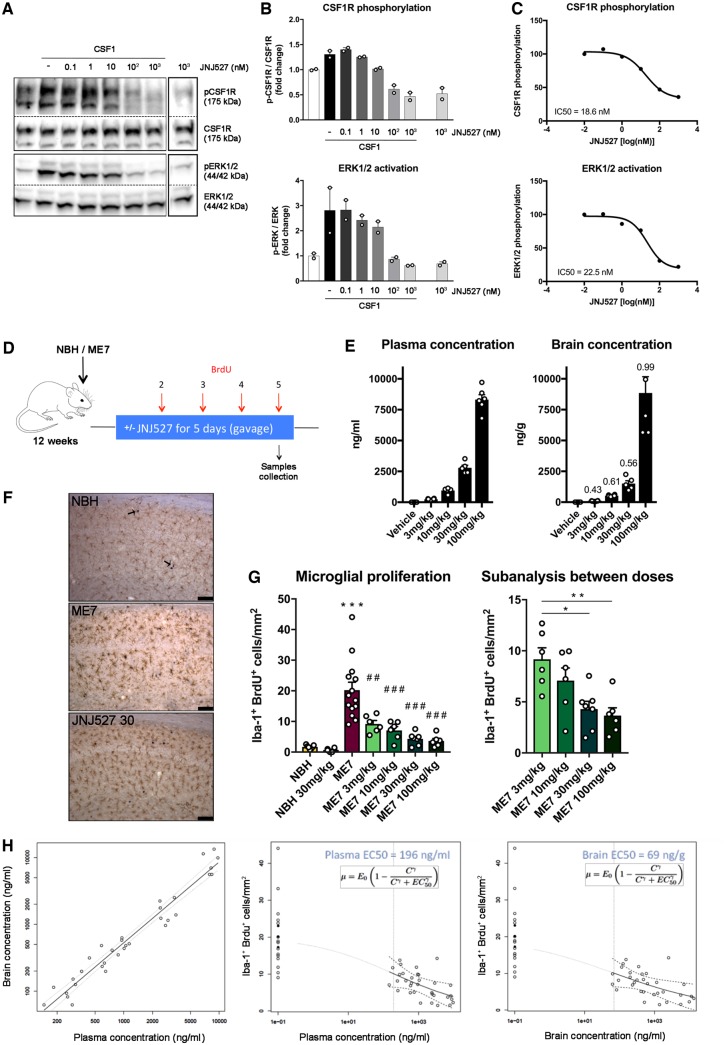

JNJ-527 prevents CSF1R phosphorylation in vitro and blocks microglial proliferation in vivo. (A) Representative western blot of N13 cells pretreated with increasing concentrations of JNJ-527 and stimulated with CSF1. (B) Quantification shows that JNJ-527 inhibits CSF1-R phosphorylation and downstream ERK1/2 activation at concentrations higher than 10 nM. Experiments were performed in triplicate, and values were corrected by the untreated control (white bars) and expressed as mean ± SEM. (C) JNJ-527 IC50 is within 18.6 and 22.5 nM. (D) Schematic representation of the experimental design used for assessing JNJ-527 efficacy in blocking microglial proliferation (NBH n = 8, NBH+JNJ-527 30 mg/kg n = 6, ME7 n = 14, ME7+JNJ-527 3 mg/kg n = 6, ME7+JNJ-527 10 mg/kg n = 6, ME7+JNJ-527 30 mg/kg n = 8, ME7+JNJ-527 100 mg/kg n = 6). Mice were treated with JNJ-527 at different doses (3, 10, 30 and 100 mg/kg) for 5 days, with four daily injections of BrdU to quantify microglial proliferation. (E) Levels of the JNJ-527 were analysed at the end of the treatment. Both plasma and brain concentration linearly correlated with the treatment dose, with T/P ratios of 0.5–1 (see numbers above columns). (F and G) JNJ-527 treatment significantly inhibited microglial proliferation in ME7 mice. Images represent Iba-1 (DAB, brown) and BrdU (alkaline phosphatese, blue) immunohistochemistry with arrows pointing to Iba-1+ BrdU+ proliferating microglia. Quantification of proliferating microglia (Iba-1+ BrdU+ cells/mm2) showed a significant reduction at all doses tested. Subsequent analysis between different doses revealed a grester effect at 30 and 100 mg/kg. (H) Pharmacokinetic/pharmacodynamics (PK/PD) model generated from the microglial proliferation data showed an EC50 of 196/ml and 69 ng/g calculated from plasmatic and brain compound concentration, respectively. (*P < 0.05, **P < 0.01 and ***P < 0.001 versus NBH; #P < 0.05, ##P < 0.01 and ###P < 0.001 versus ME7).